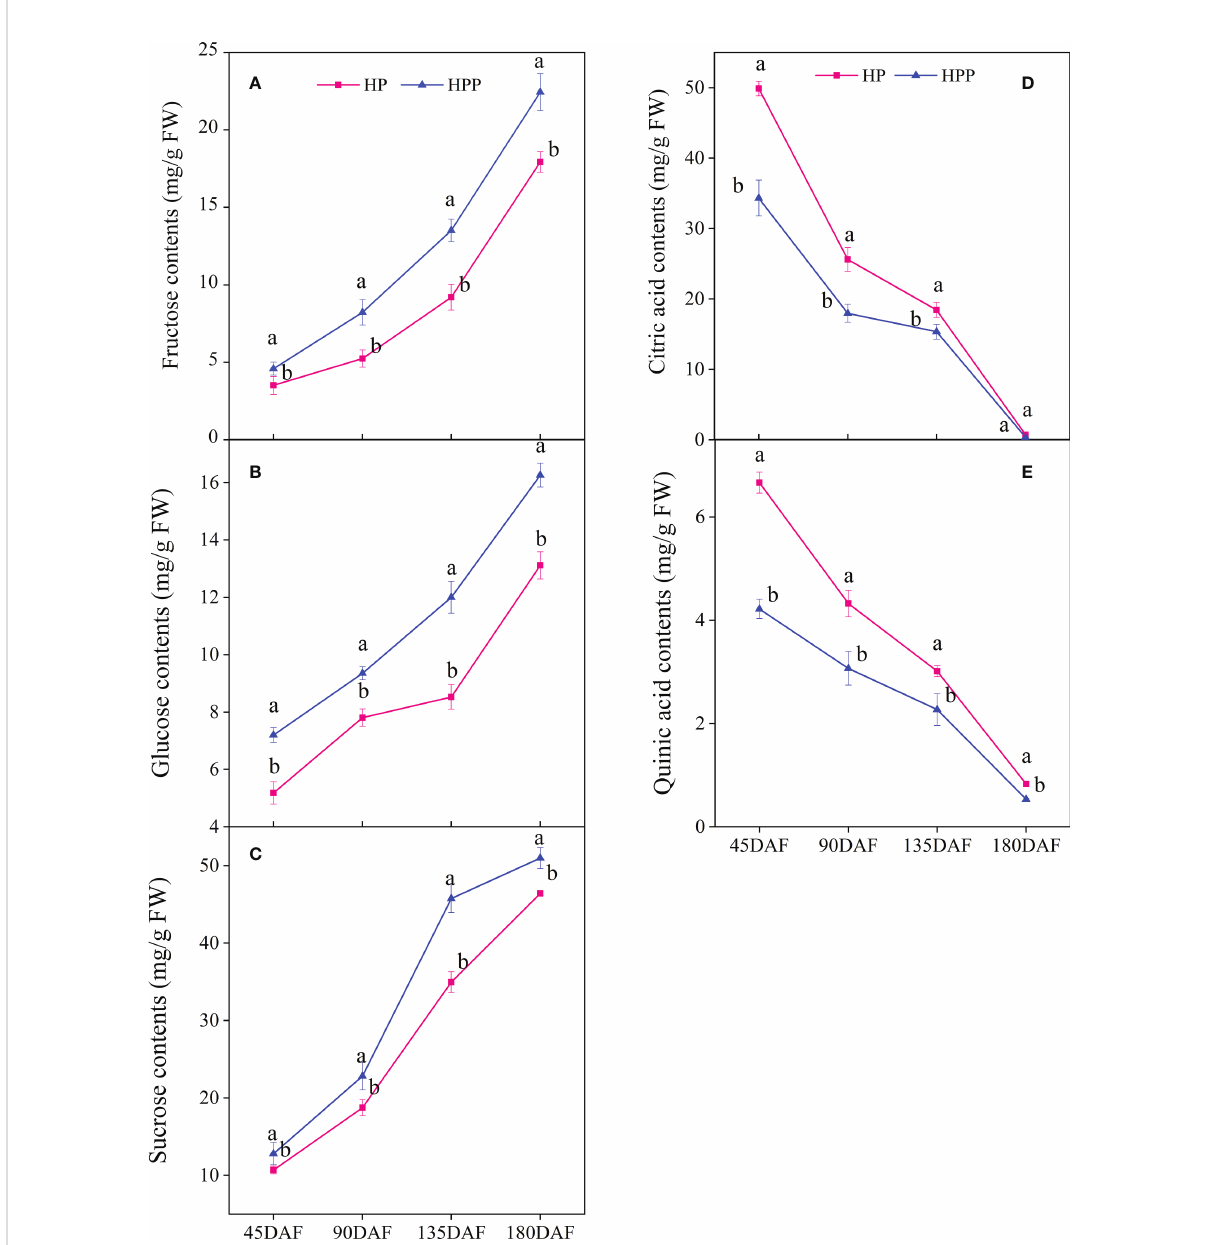
FIGURE 2 Changes in sugar and acid content between Harumi/Hongjv (HP) and Harumi/Ponkan/Hongjv (HPP). (A) fructose contents, (B) glucose contents, (C) sucrose contents, (D) citric acid contents, (E) quinic acid contents in HP and HPP fruits at 45, 90, 135, and 180 days after fl owering (DAF). Each value shown represents the mean of three biological